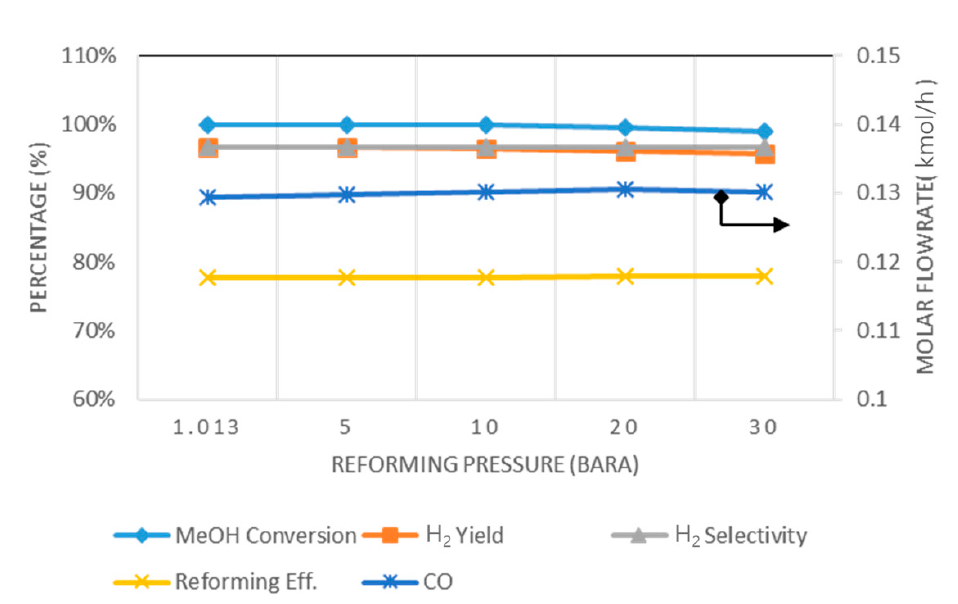
Figure 7. Effect of reforming pressure on MeOH conversion, H 2 yield, H 2 selectivity, reforming efficiency and CO flow rate.